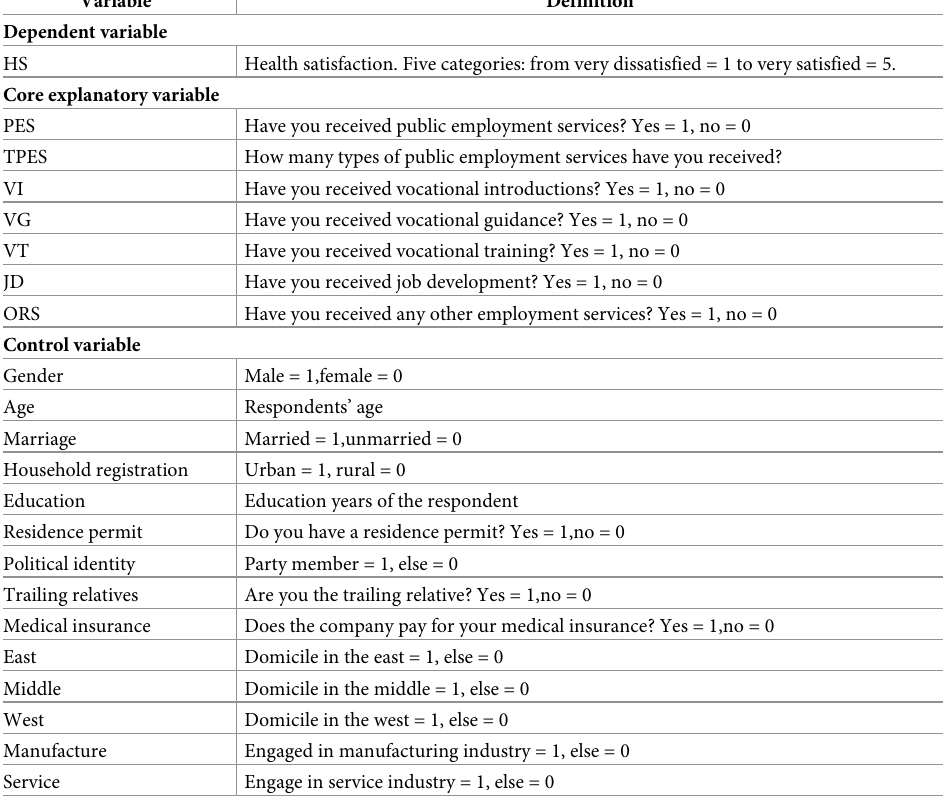
Table 11. Definition of